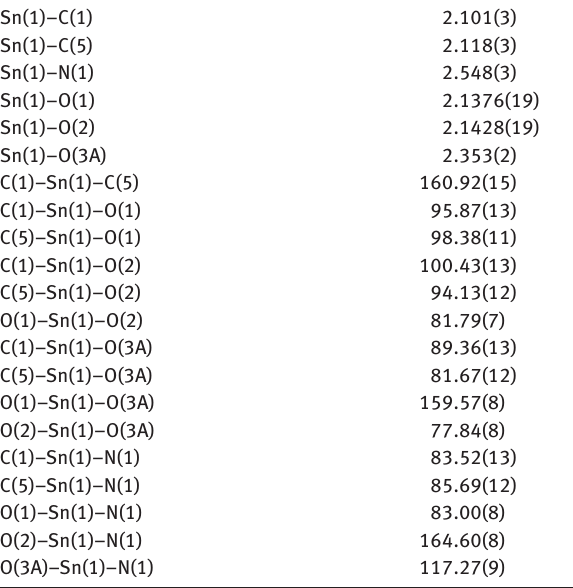
Table 1: Selected bond lengths (Å) and angles ( ° ) for 1